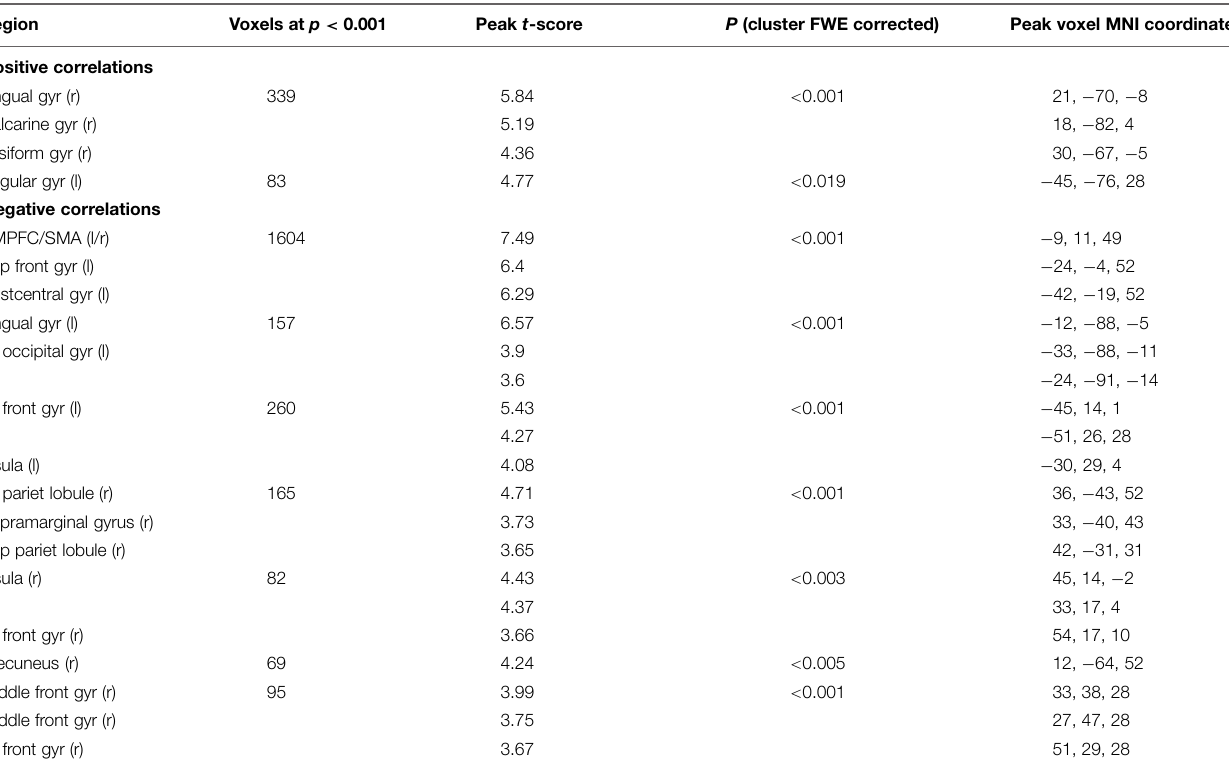
TABLE 2 | Areas showing significant correlations with subjective certainty ratings in color trials (cluster-defining threshold p < 0.001, uncorrected; reported changes in BOLD signal corrected for multiple comparisons at p < 0.05, whole brain corrected). Region Voxels at p < 0.001 Peak t